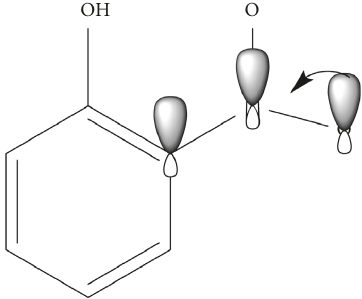
Figure 6: Resonance structure of 2NPH. Table 5: Second-order perturbation theory analysis of Fock matrix in NBO basis for the respective phenols.